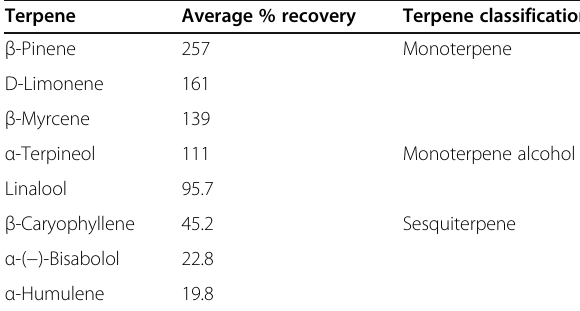
Table 2 Terpene profile recoveries for each terpene in the DjG preservation samples. Recoveries calculated by comparing results to theoretical value of the formulated 8-part mixture to inflorescence terpene profiles after storage in the presence of the mixture